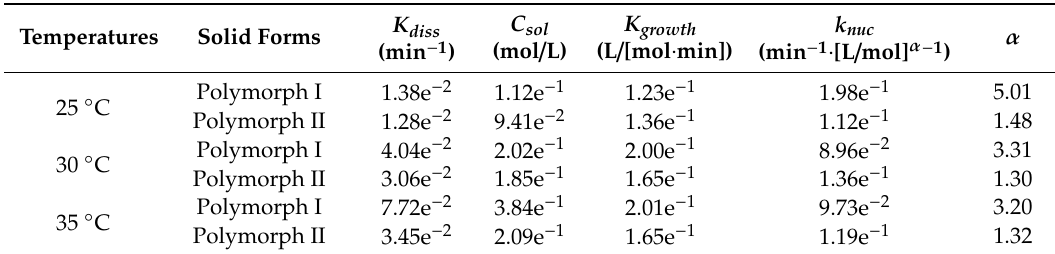
Table 1. Parameters for Theophylline in various temperatures in solution-mediated transformation processes.